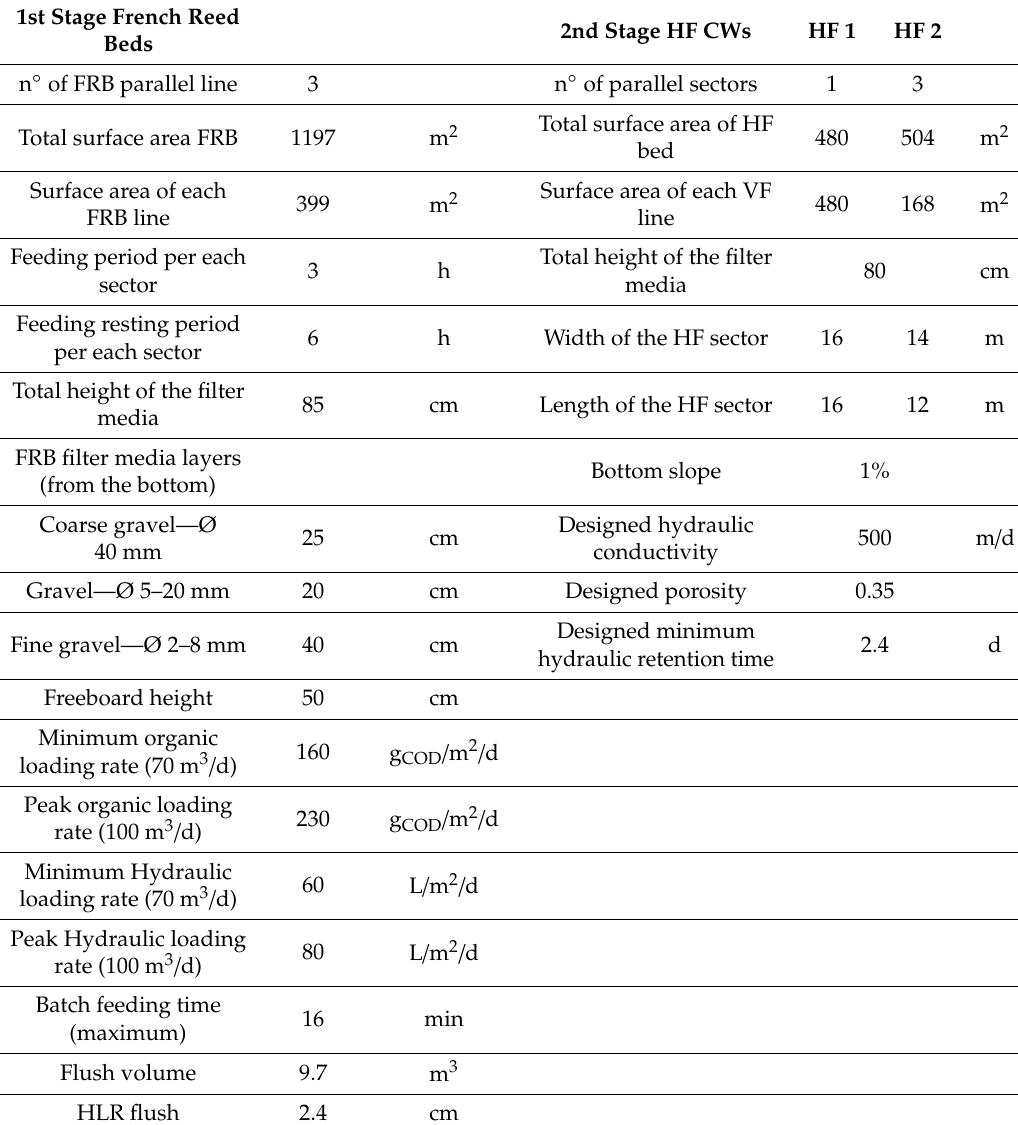
Table 1. Technical specifications of the Cecchi CW WWTP: HF 1, refurbished bed from 2001 CW WWTP; HF 2, bed built during the 2009